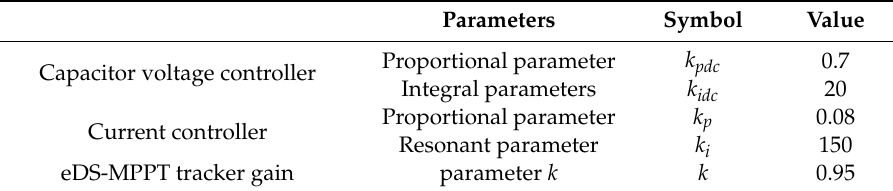
Table 3. Controllers